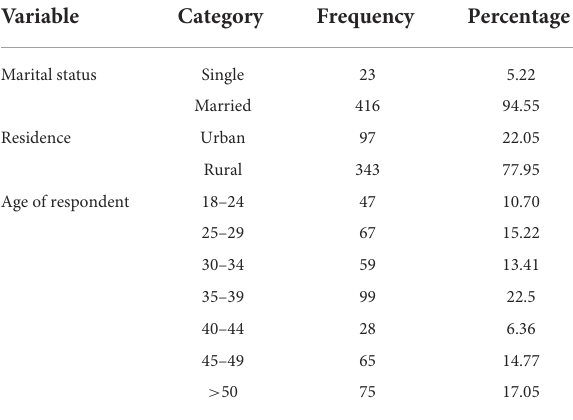
TABLE 1 Sociodemographic of patients with pelvic organ prolapse at Asella Teaching Referral Hospital (ATRH), 2021.